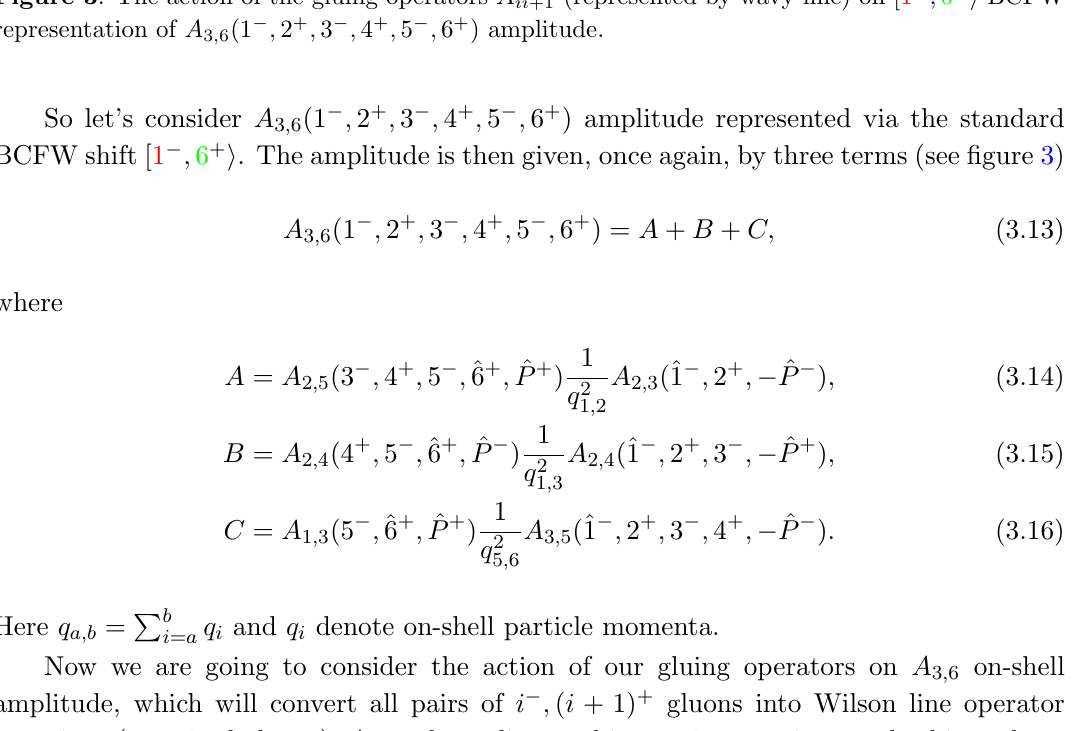
+1 (represented by wavy line) on [1